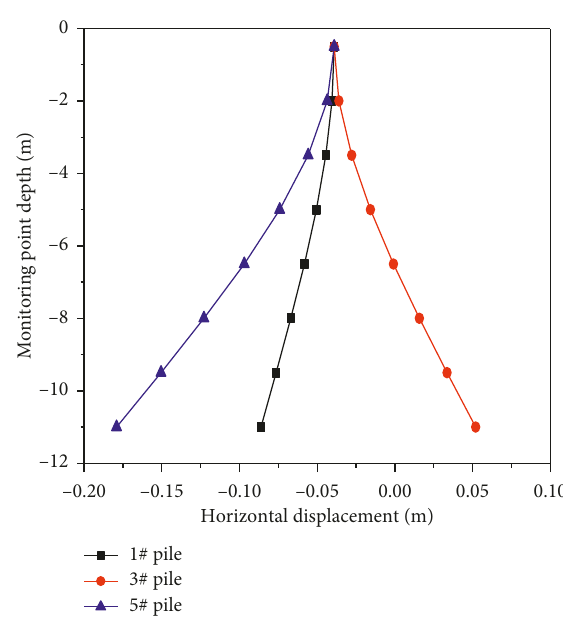
Figure 8: Horizontal displacement of the